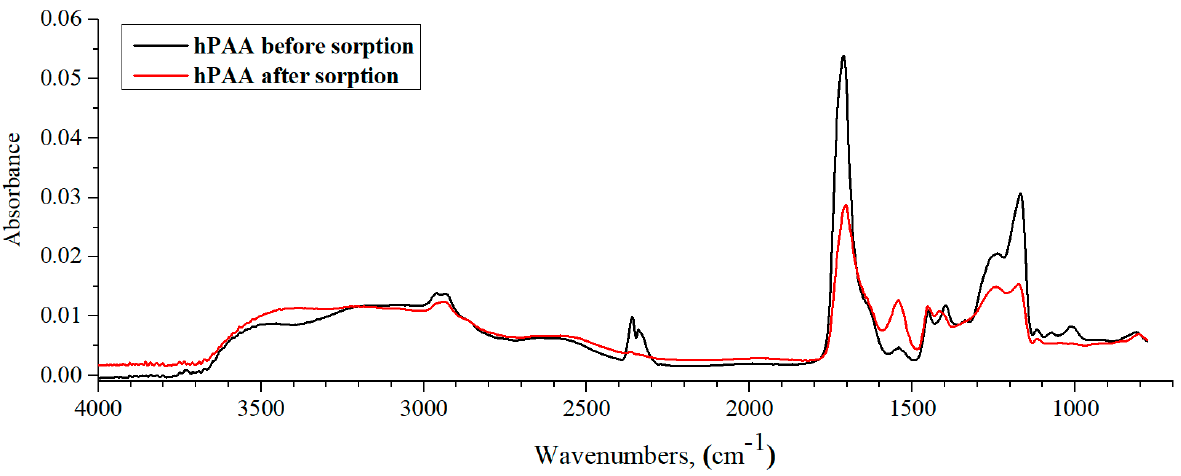
Figure 8. IR spectra of hPAA before and after lanthanum sorption by interpolymer system 33%hPAA-67%hP4VP.